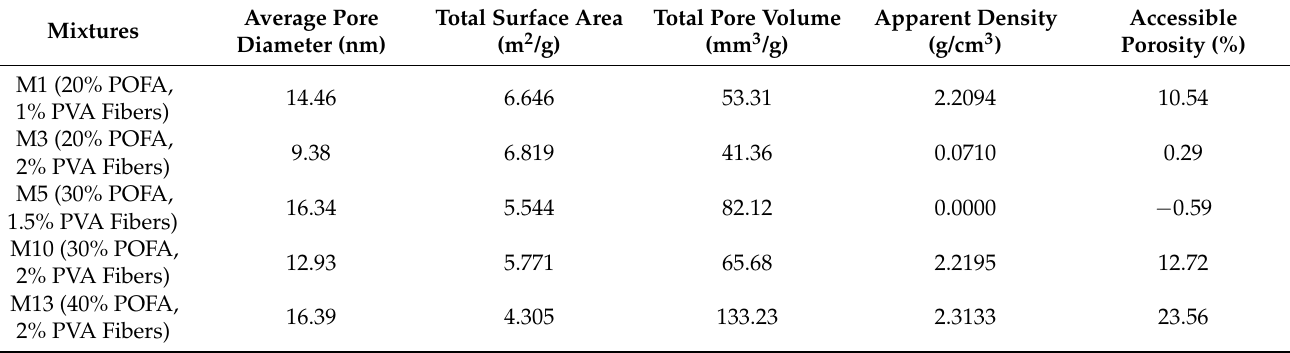
Table 4. Critical pore parameters of POFA-ECC.